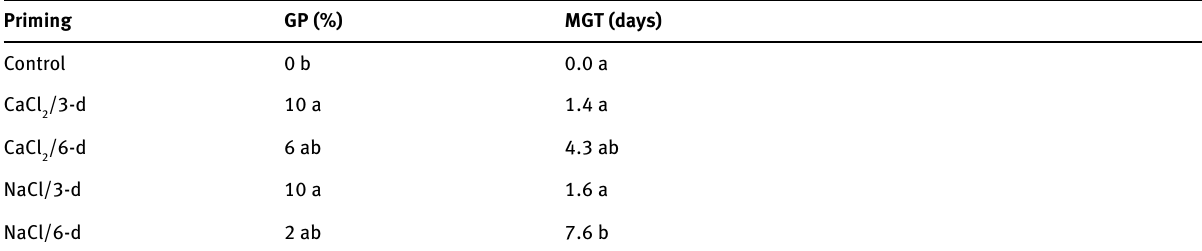
Table 3: Effect of different osmotic agents and priming durations on germination percentage (GP) and mean germination time (MGT) of melon seeds at 12°C and -1.0